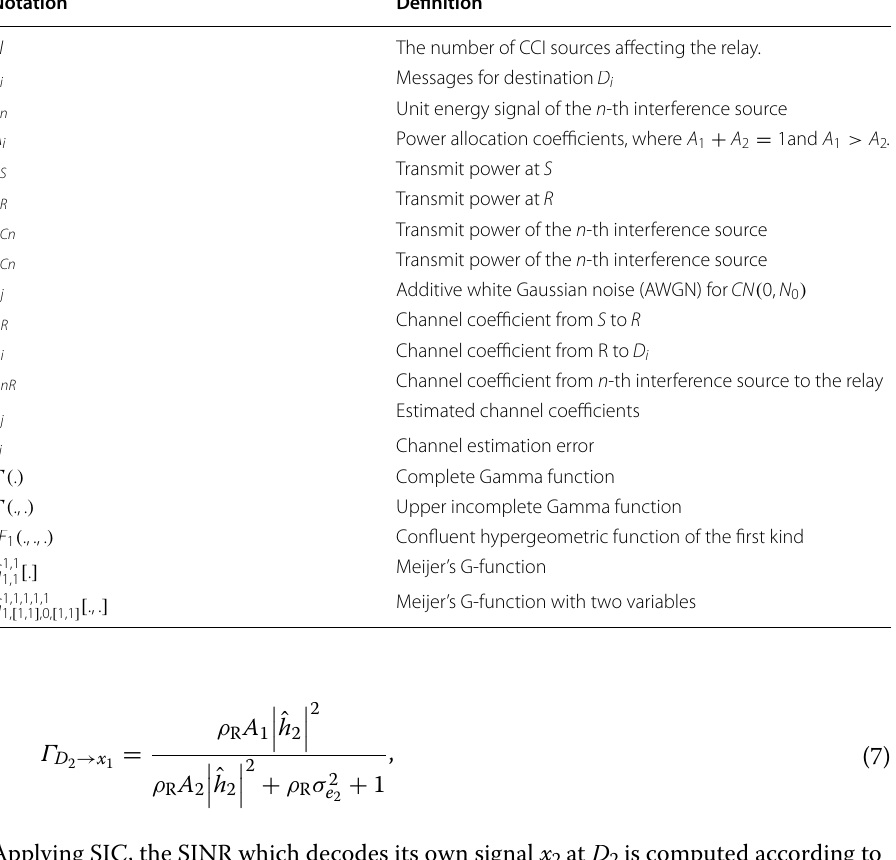
Table 2 Table of parameters